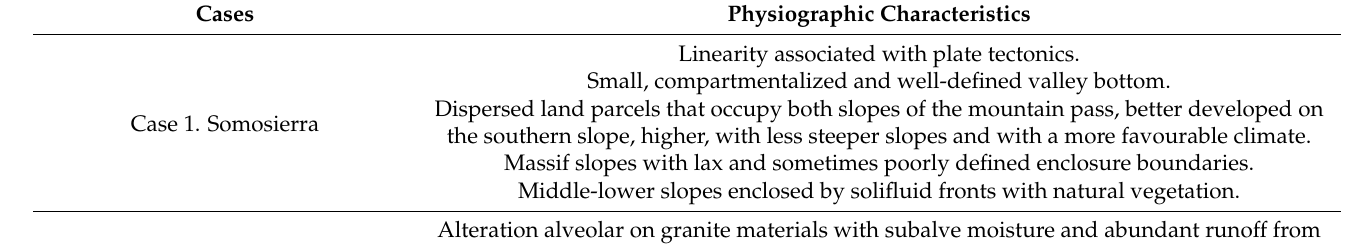
Table 1. Physiographic characteristics of the case studies.